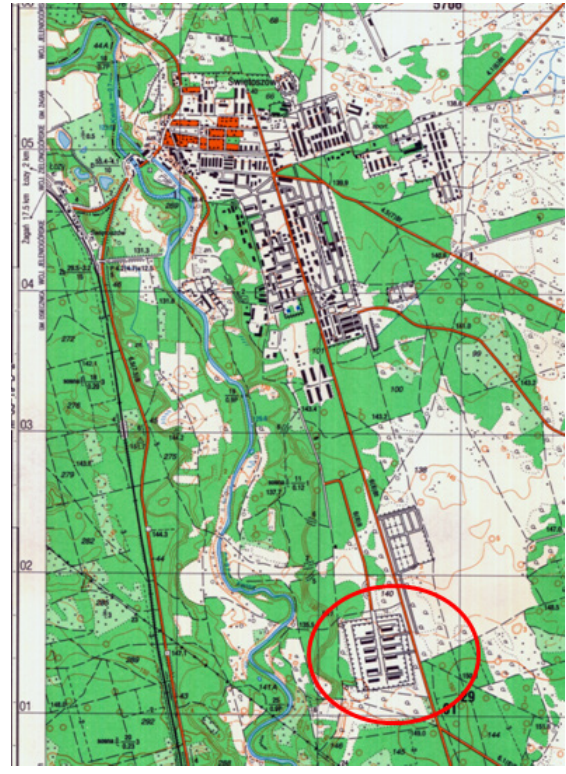
Fig. 13. A part of the map 1:25,000 (“Model 1990”, 1992) of the Świętoszów garrison with full barracks and training ground